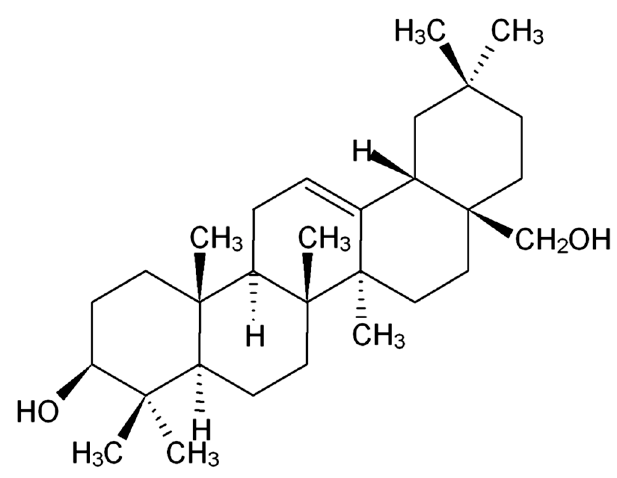
Figure 1. Erythrodiol chemical structure.